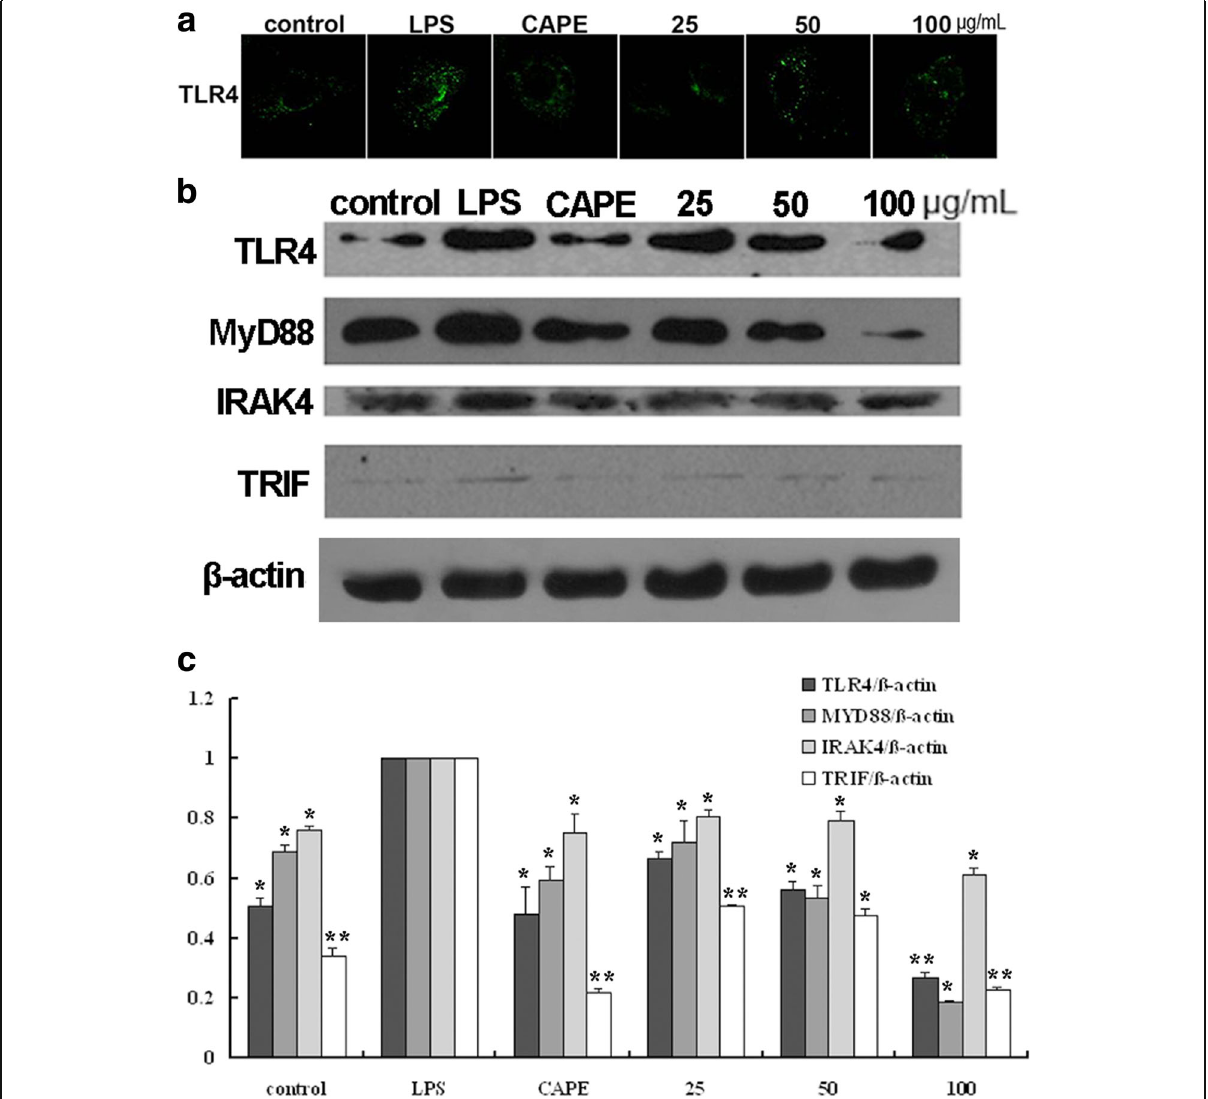
Fig. 6 EECP and CAPE regulated the levels of TLR4, MyD88, IRAK4 and TRIF. a Cells were treated with EECP and CAPE for 24 h, respectively. Cells were stained with anti-TLR4 antibody. Immunofluorescence graphs showed a decrease of TLR4 level. b The expression of TLR4, MyD88, IRAK4 and TRIF in LPS-stimulated MDA-MB-231 cells were detected by western blotting at 48 h. c Quantification of relative expression of TLR4, MyD88, IRAK4 and TRIF in LPS-stimulated MDA-MB-231 cells. ( * P < 0.05, ** P < 0.01 vs control, n = 3). Data are means ±